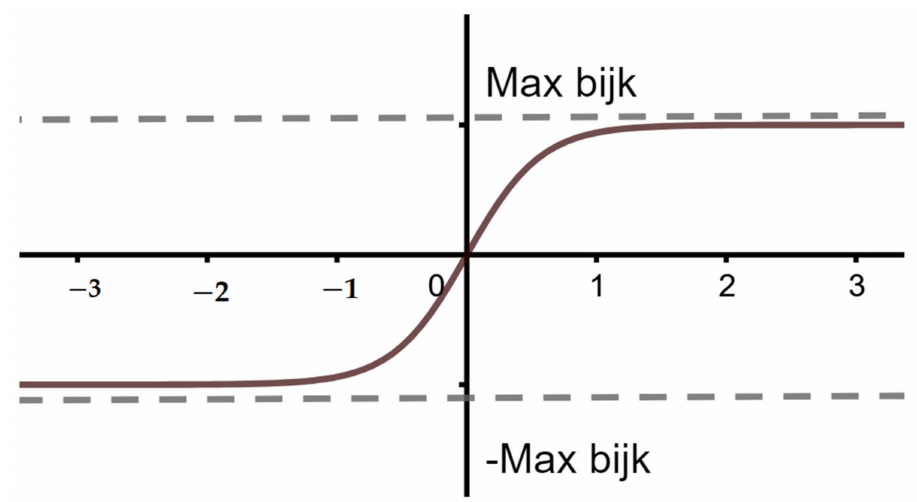
Figure 7. TanSigmoid function with small